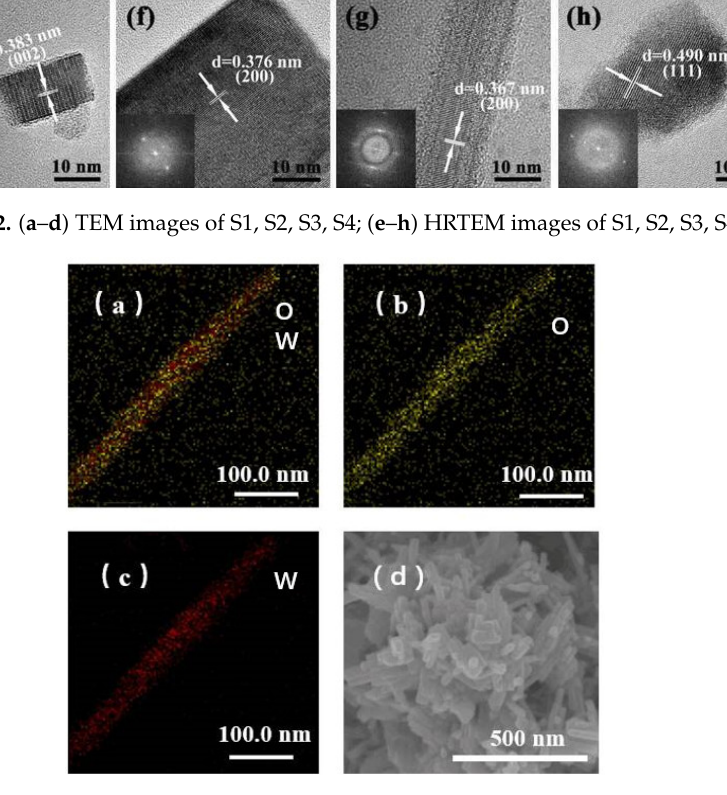
Figure 3. ( a – c ) Elemental mapping of S3; ( d ) FESEM image of S3.